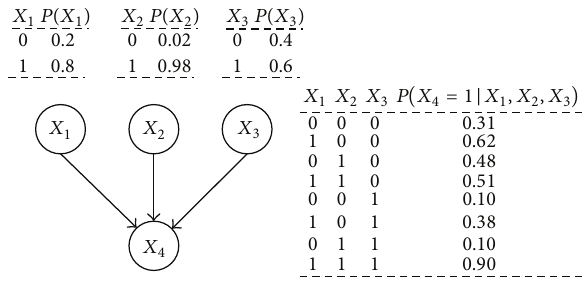
Figure 1: A diagram of Bayesian